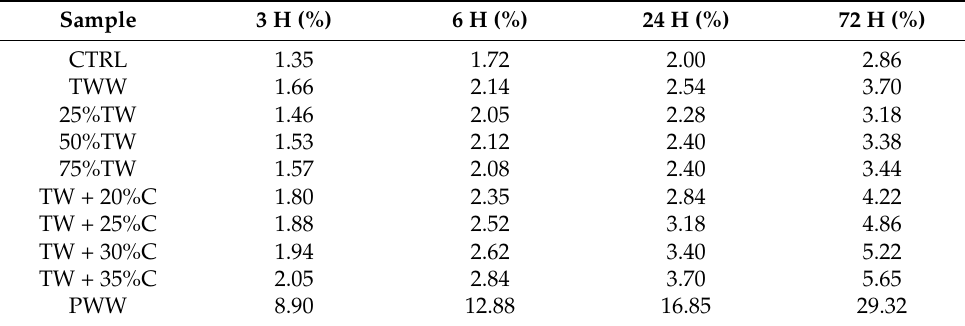
or mm). (cid:3040)(cid:3040) (cid:3118) or mm). mm 2